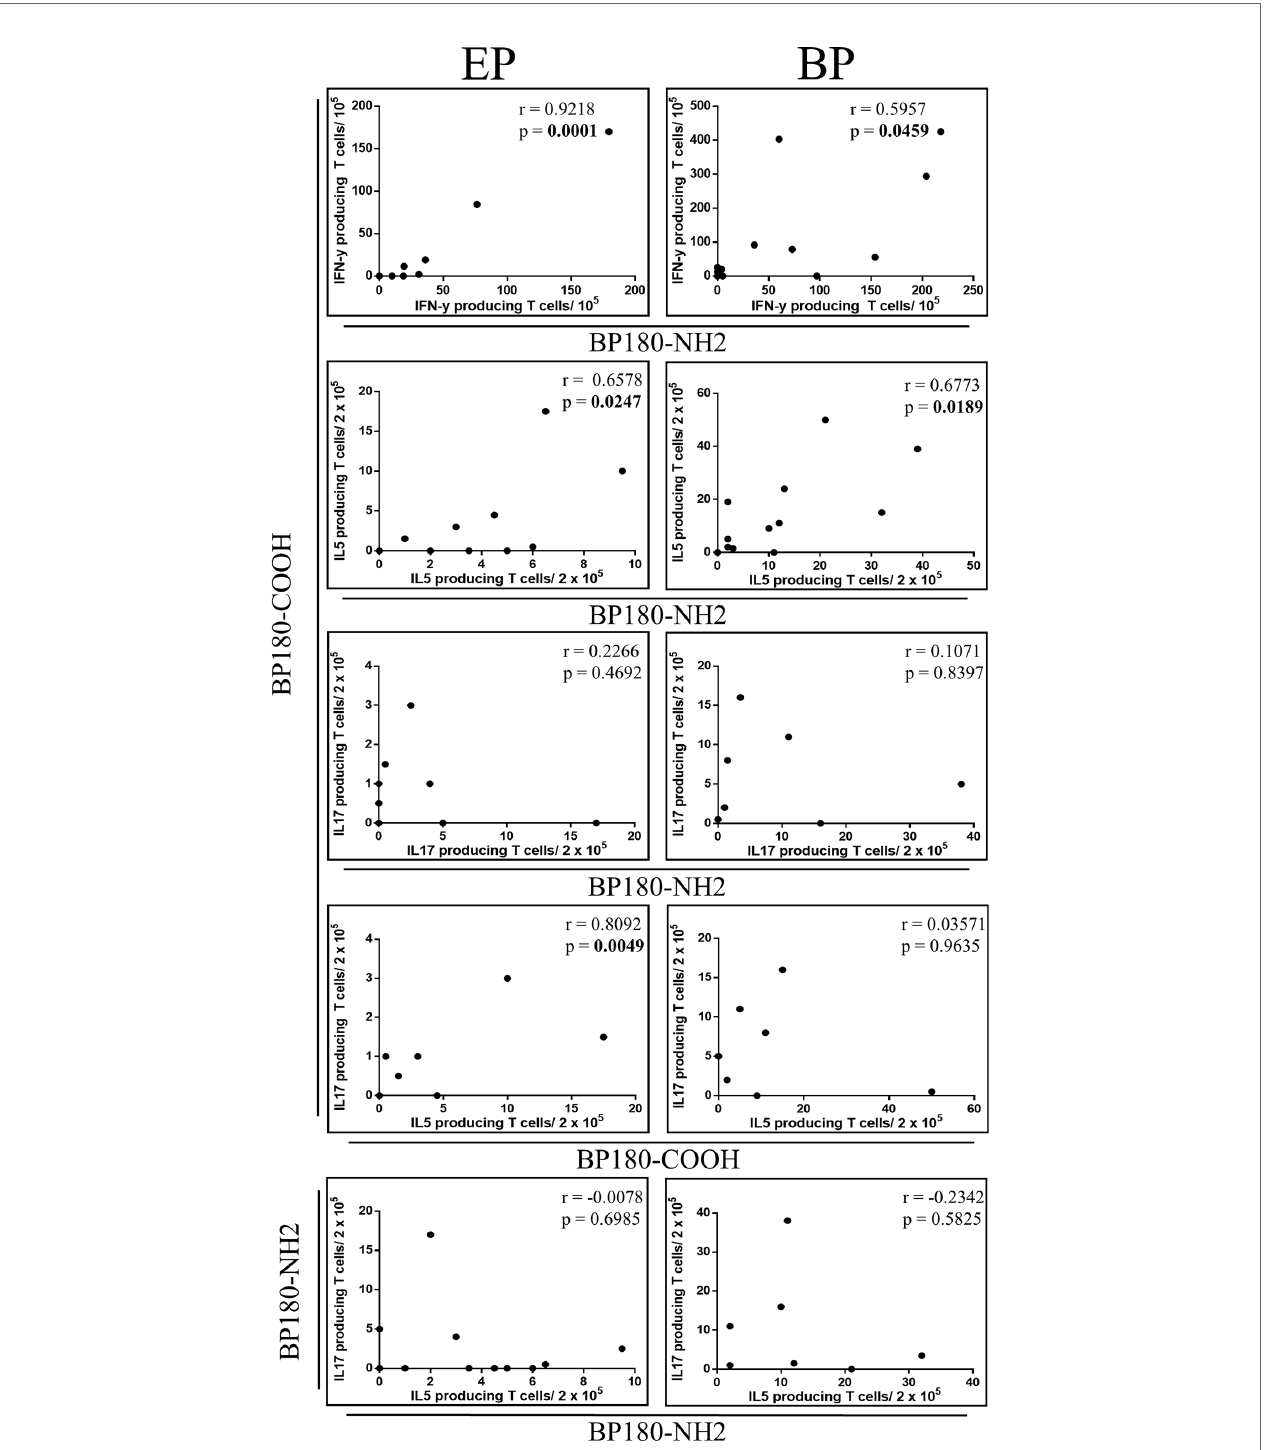
FIGURE 3 | Relationship between pro- and anti-in fl ammatory autoreactive T cell responses against bullous pemphigoid (BP) 180 in elderly patients with pruritic disorders (EP). Plots showing correlations of anti-in fl ammatory and pro-in fl ammatory cytokine producing T cells speci fi c for BP180-NH2 or BP180-COOH, respectively. From top down: relationship between IFN- g producing T cells, IL-5 and IL-17, upon stimulation with BP180-COOH or BP180-NH2 between EP and BP patients. Correlation between IL-17-producing T cells and IL-5-producing T cells upon stimulation with BP180-COOH for EP and BP patients. Correlation between IL17-producing T cells and IL-5-producing T cells upon stimulation with BP180-NH2. Spearman ’ s correlation coef fi cients (r) are shown with signi fi cant p values (p <0.05) highlighted in